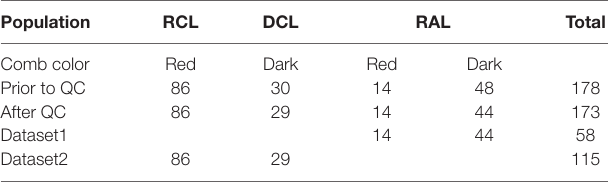
TABLE 1 | Description of the samples used in the genomic analyses.